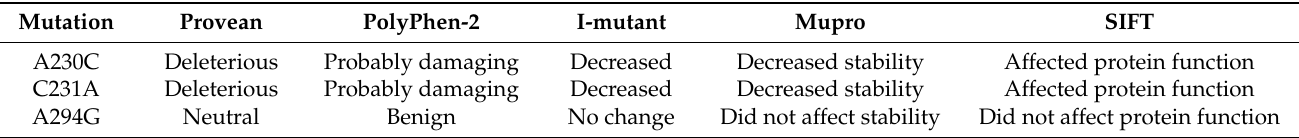
Table 11. Validation of results obtained from different bioinformatical